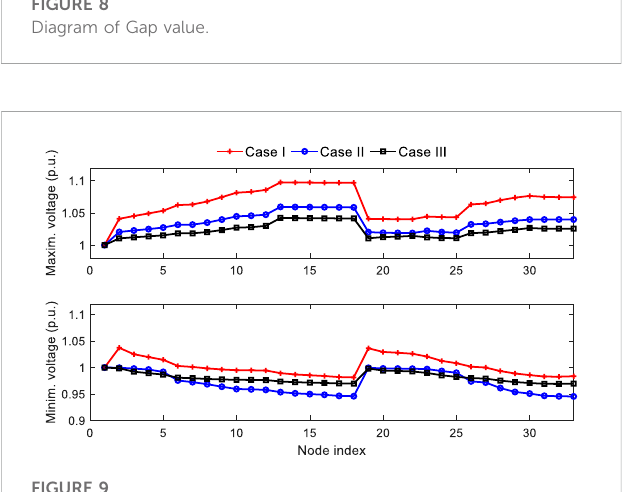
FIGURE 9 Comparison of the maximum and minimum voltages in the three cases.